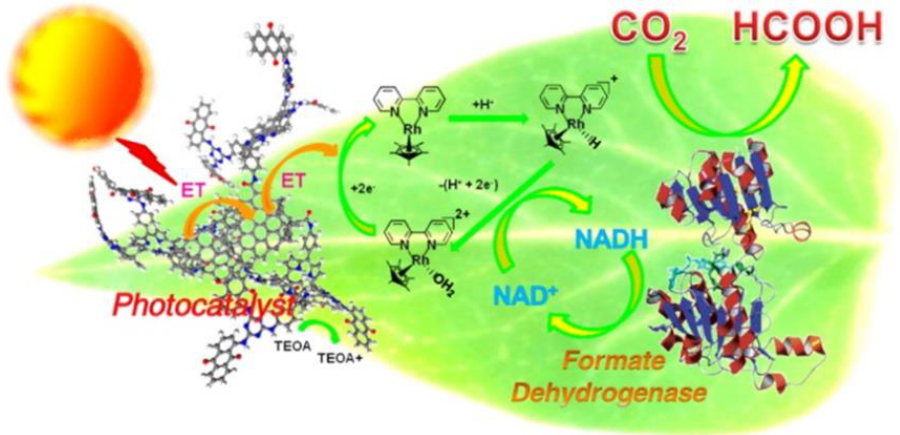
Figure 7. Graphene-based photocatalyst catalyzed artificial photosynthesis of formic acid from CO 2 under visible light [116].